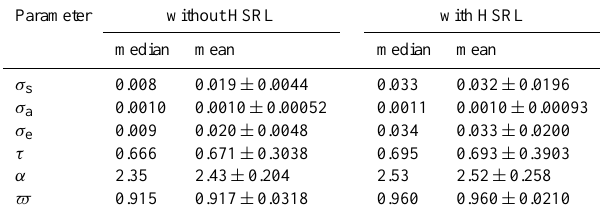
Table 4. Derived aerosol parameters. The mean and median are calculated for the set of optimizations. Uncertainties (denoted ± ) are the median value returned by the optimization routine. Optical thickness ( τ ), scattering, absorption and extinction cross-sections ( σ s , σ a and σ e ), and single scattering albedo ( $ ), are all expressed at 532nm.